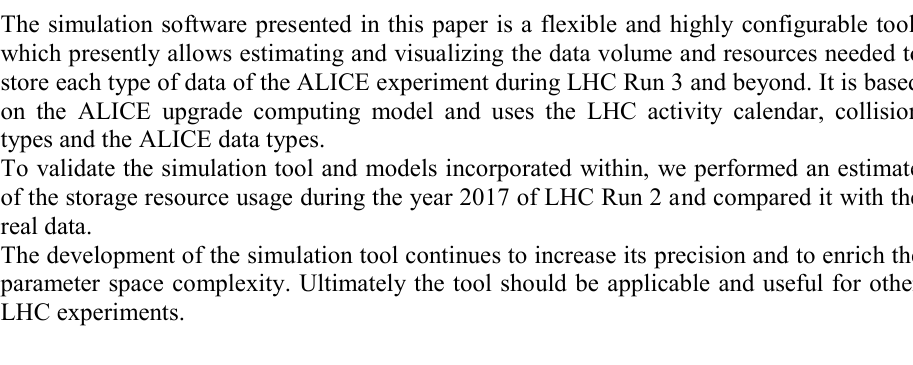
Table 3. Data types, replication factors, storage sharing and lifetime for Pb-Pb collisions.